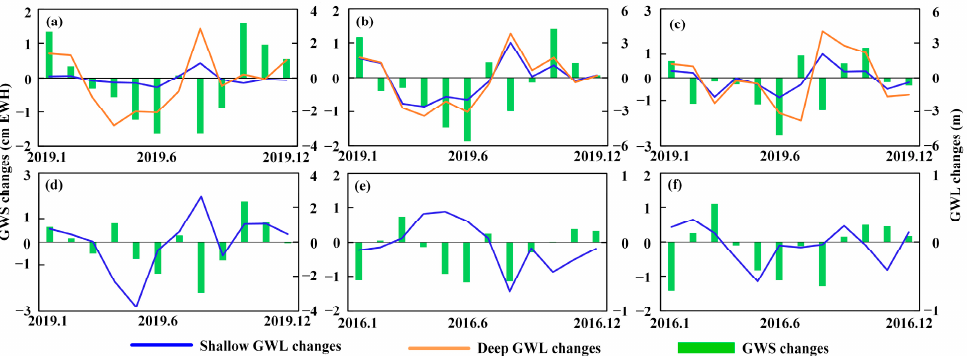
Figure 12. Comparison of monthly GWL changes and GWS changes. ( a – d ) represent the monthly GWL changes and GWS changes in Cangzhou, Xingtai, Handan, and Tangshan, respectively, in 2019; ( e , f ) represent Beijing and Tianjin in 2016, respectively.